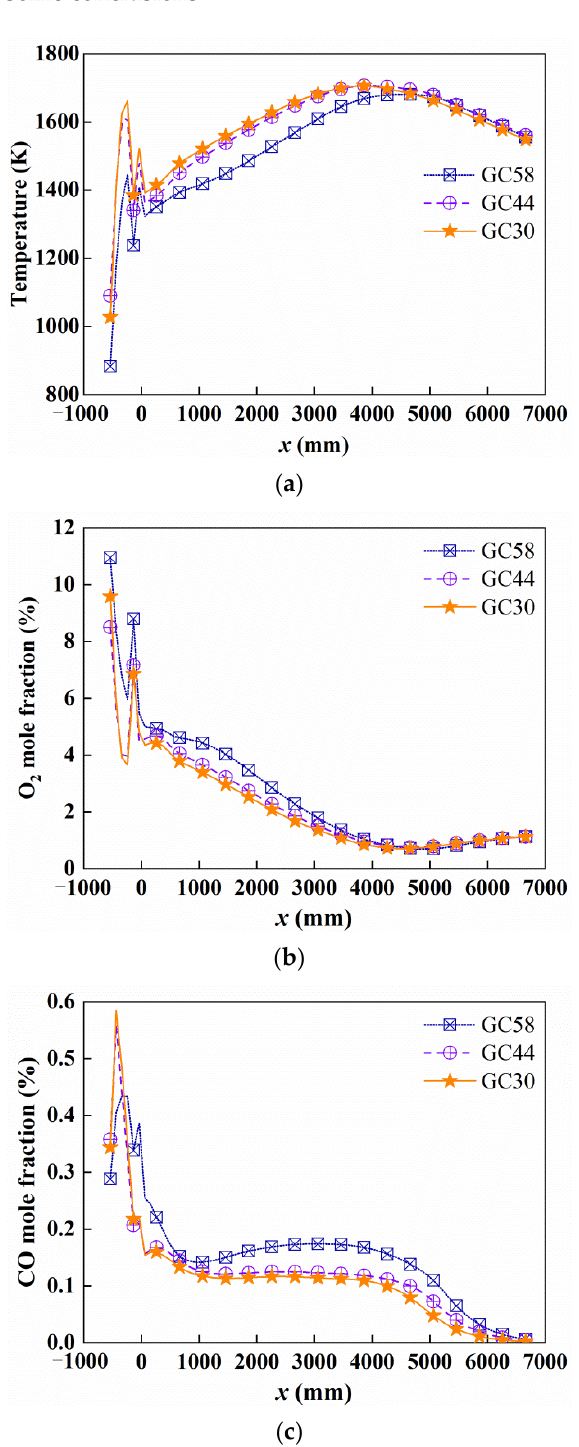
Figure 11. Distribution of the average temperature and species mole fraction along x -axis. ( a ) Tem- perature distribution. ( b ) O 2 mole fraction distribution. ( c ) CO mole fraction